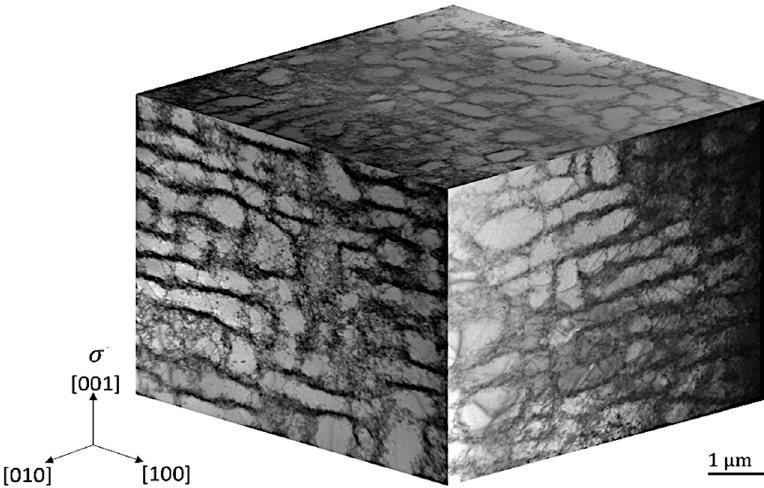
Figure 2. A transmission electron microscope “cube” based on images taken from the (100), (010), and (001) planes of a copper specimen cyclically deformed to saturation as shown in Figure 1a. The stress axis is parallel to the [001] direction (Taken from Ref. [1]).